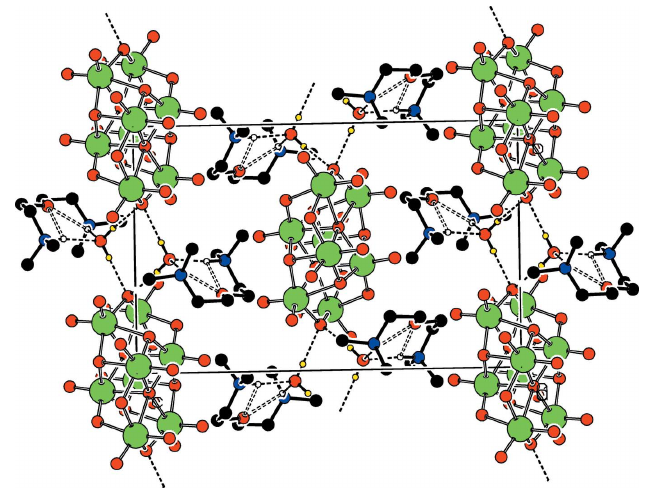
Figure 2 Part of the crystal structure with N—H (cid:2)(cid:2)(cid:2) O and O—H (cid:2)(cid:2)(cid:2) O hydrogen bonds shown as dashed lines viewed along the [100] direction of the unit cell.